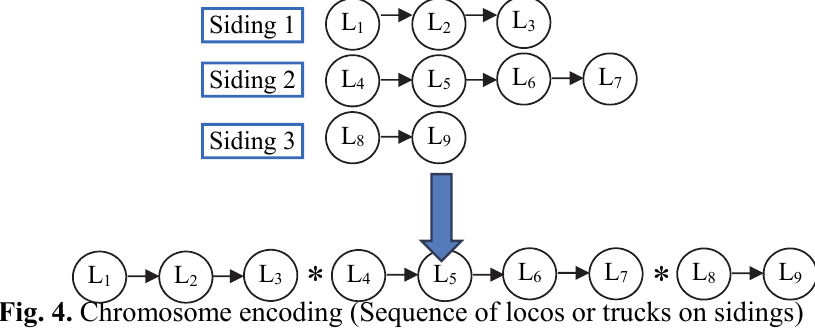
Fig. 4. Chromosome encoding (Sequence of locos or trucks on